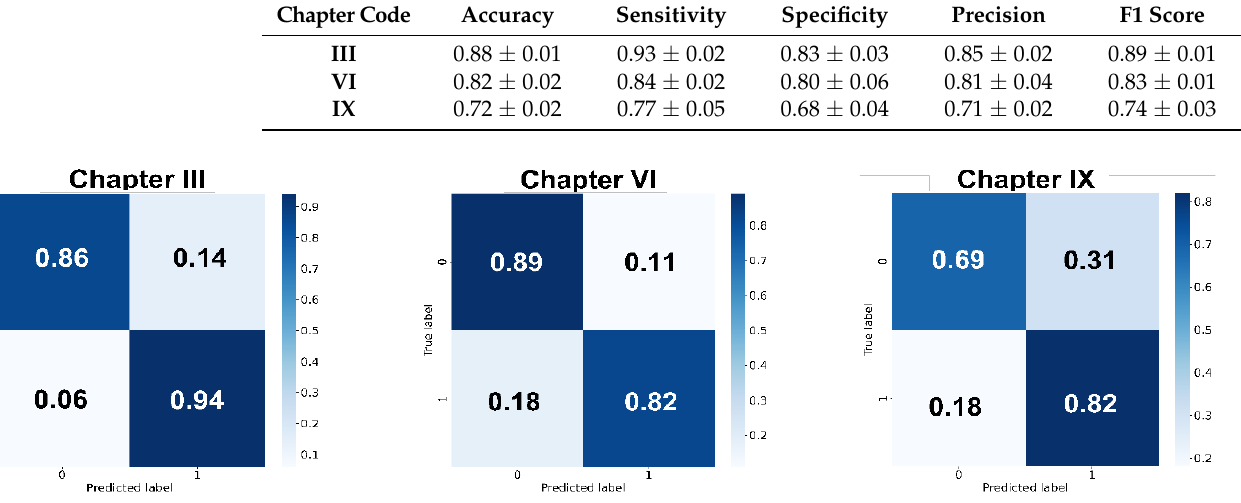
Figure 6. Normalized confusion matrix for the test unseen dataset.